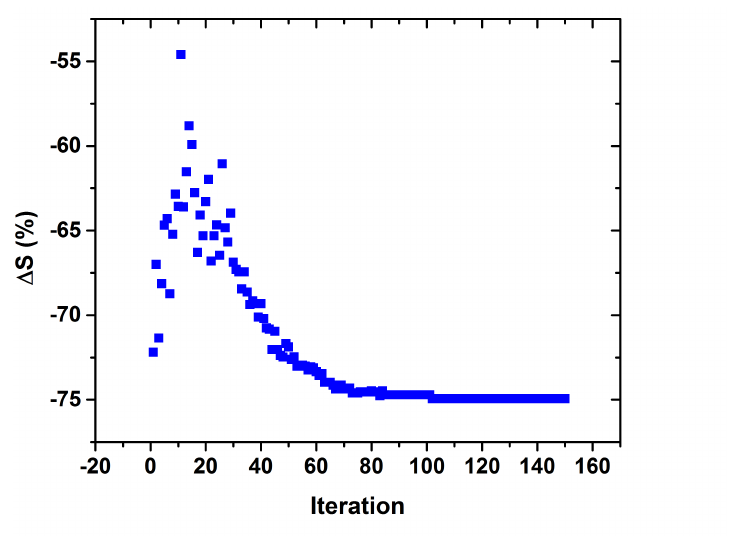
Figure 14. Percentage difference of distance of particles with diameter of 800 nm from the desired trajectory between the original and the minimized carotid artery under inlet velocity of 0.08